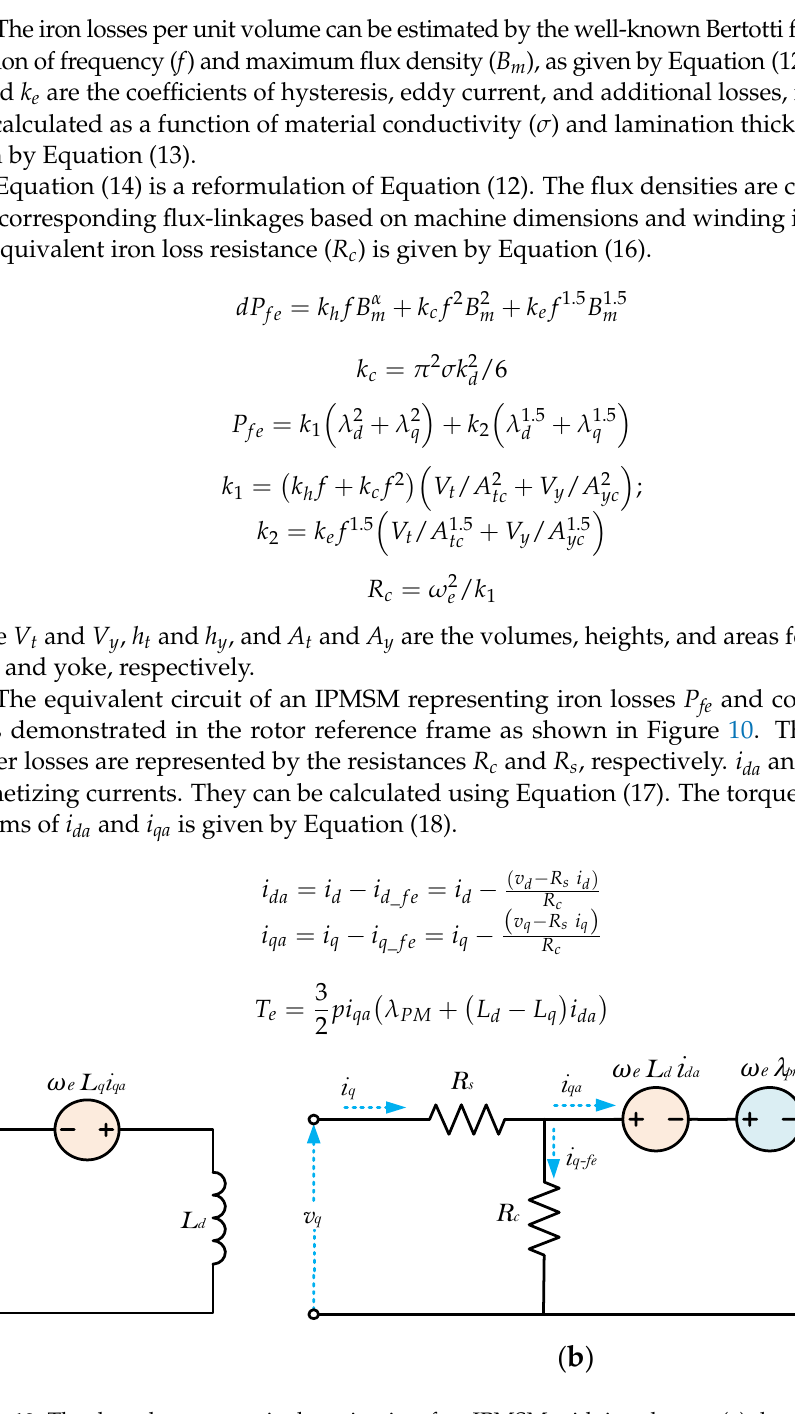
Figure 10. The d- and q-axes equivalent circuits of an IPMSM with iron losses: ( a ) d-axis, ( b ) q- axis.